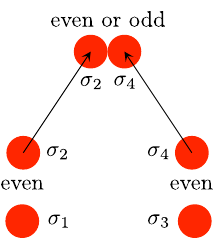
⊗ σ = ψ ⊕ (cid:73) of Majorana Figure 1: Schematic illustration of the fusion rule σ 2 4 zero-modes (red dots, labeled σ ). Pairs of zero-modes may or may not share a n quasiparticle. In the former case the fermion parity is “odd” (indicated by ψ ), in the latter case it is “even” (indicated by (cid:73) ). The overall fermion parity is conserved, so if the fusion of σ and σ leaves behind a quasiparticle, then the fusion of σ and σ 2 4 1 3 must also produce a